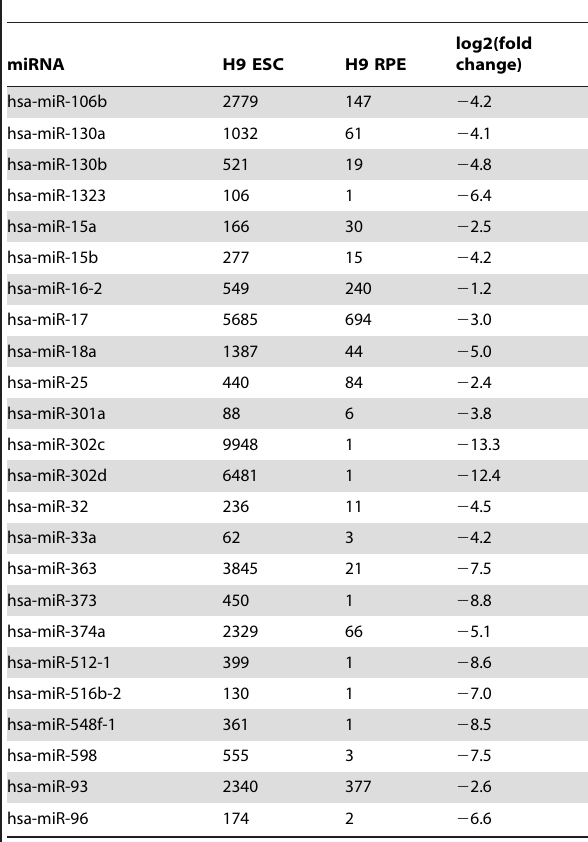
Table 1. Downregulated miRNAs in RPEs during ESC differentiation.